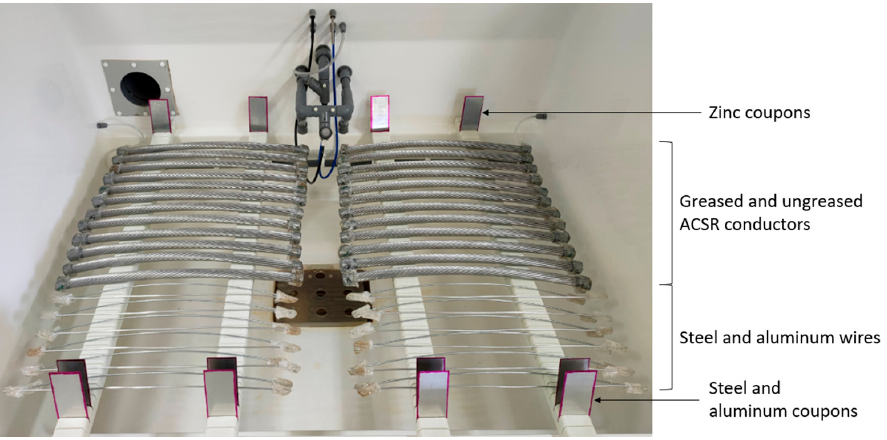
Figure 2. Wire and cable arrangement in the corrosive chamber.